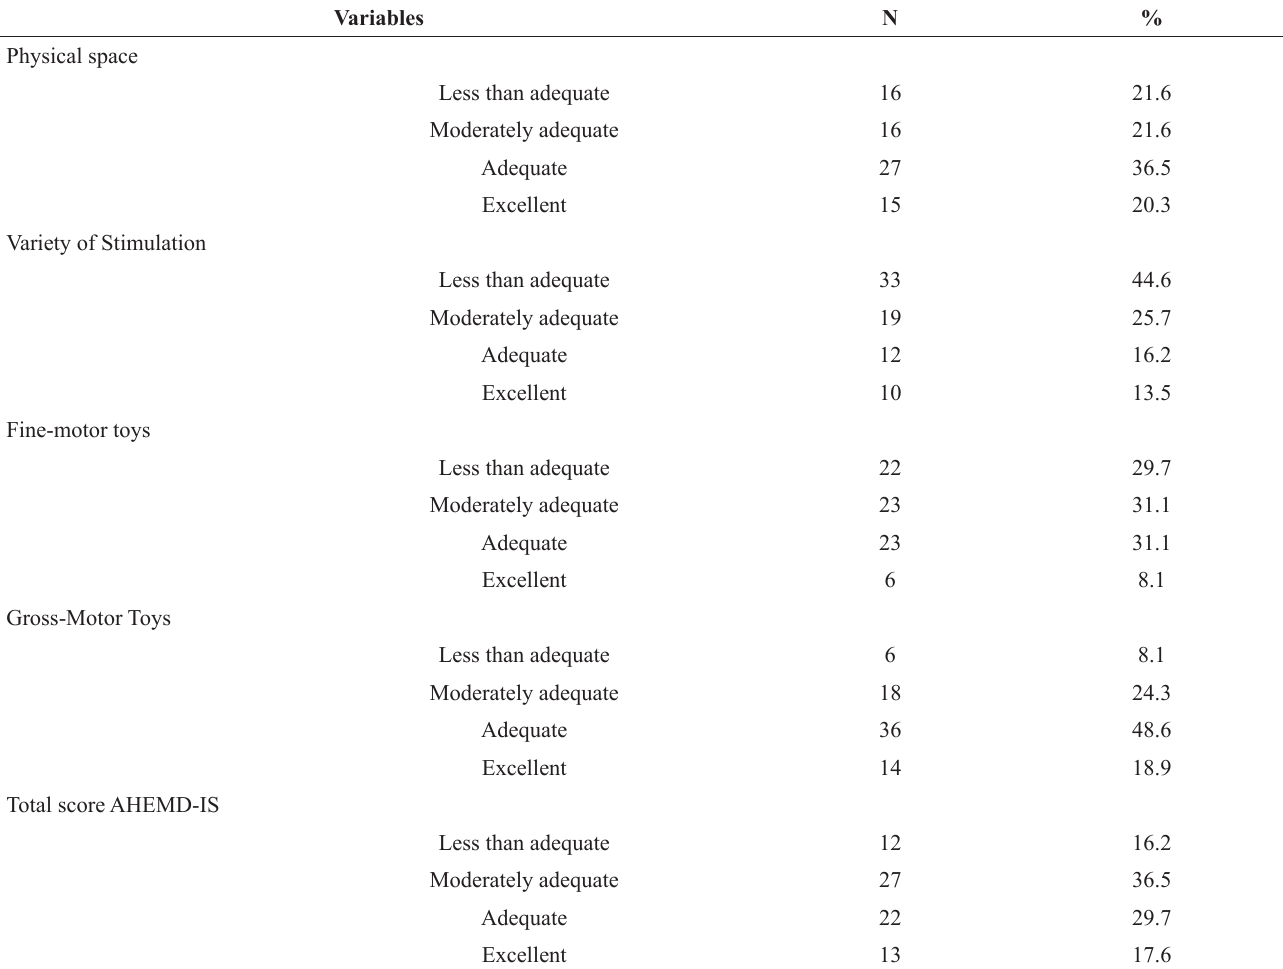
Table 2 - AHEMD-IS classification and its dimensions (n = 74).